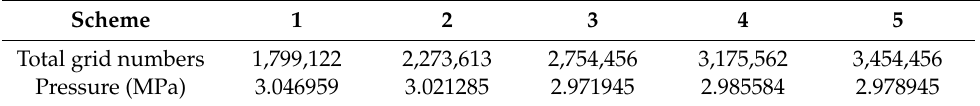
Table 2. Grid independence